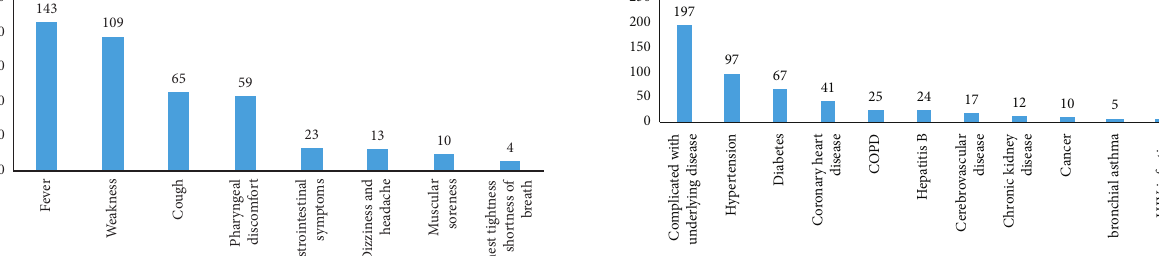
Figure 2: Underlying diseases in COVID-19 patients.